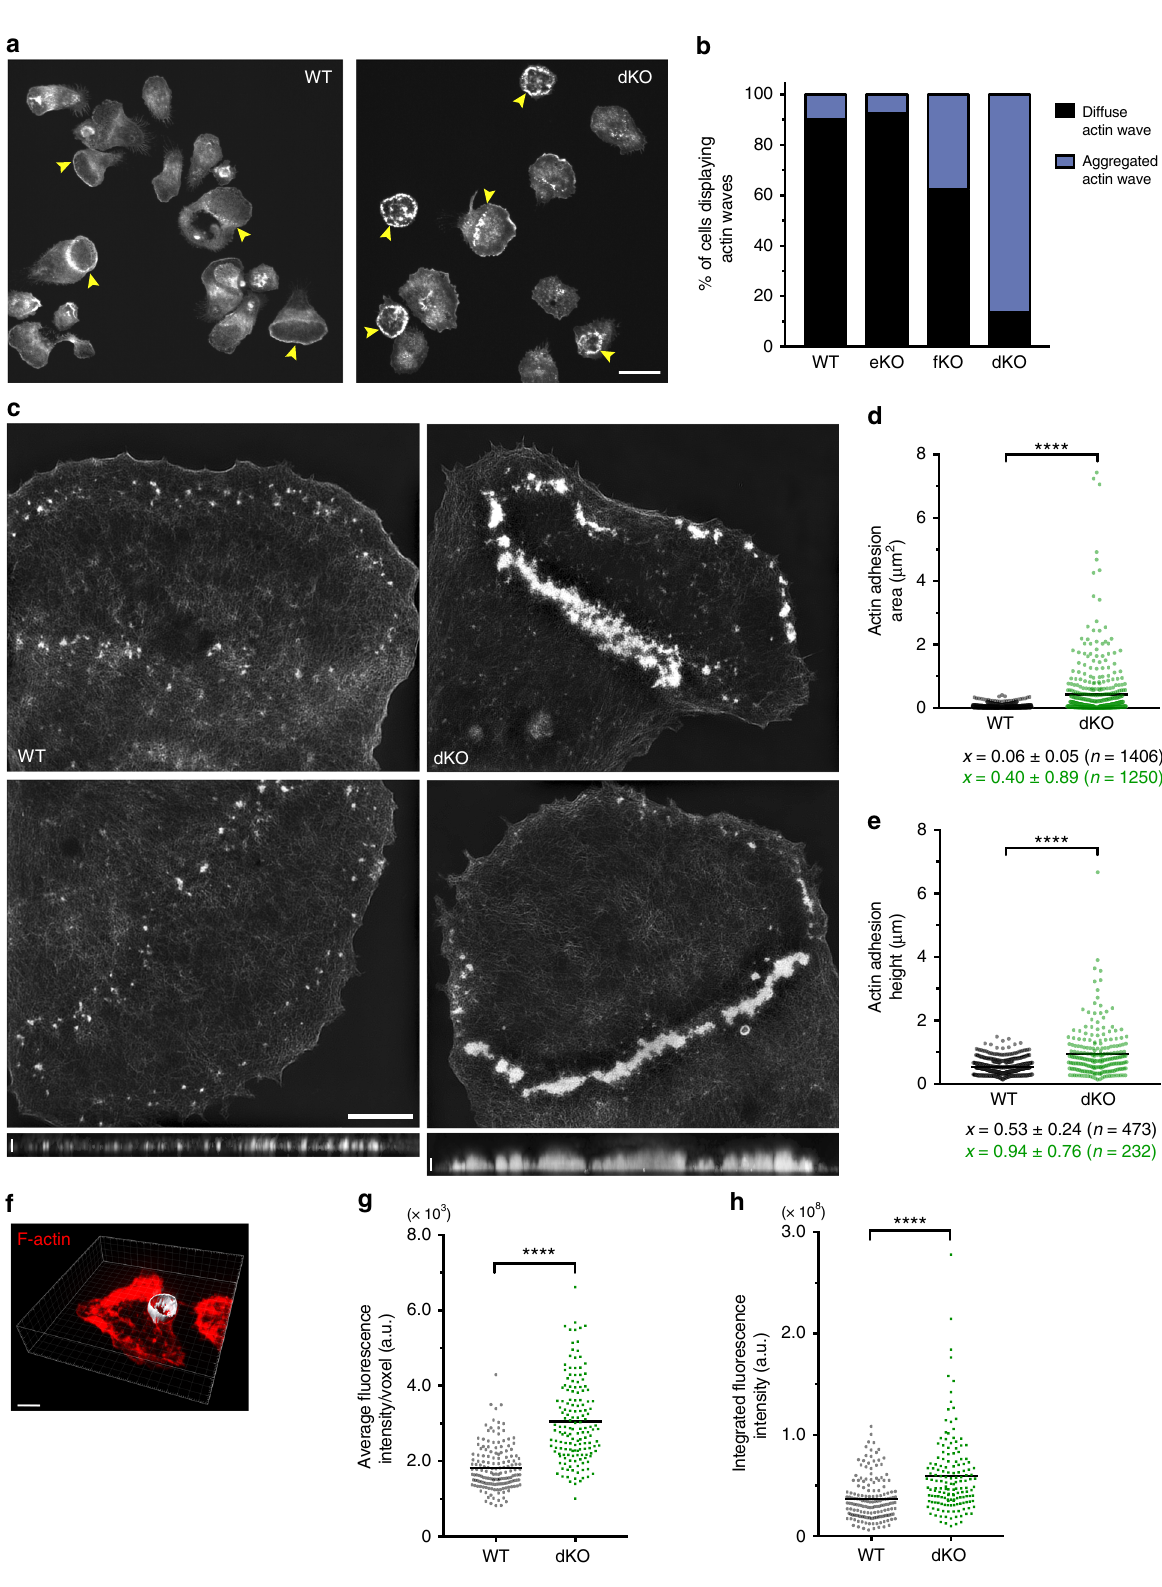
be concentrated at the base of these structures (Fig. 3b, c). We tested whether these myosin-I/actin puncta were associated with FcR clusters by transfecting cells with EGFP-Fc γ RIIA. As has been previously observed, macrophages spreading on IgG formed discrete FcR clusters 41,42 . We found that myo1f and Fc γ